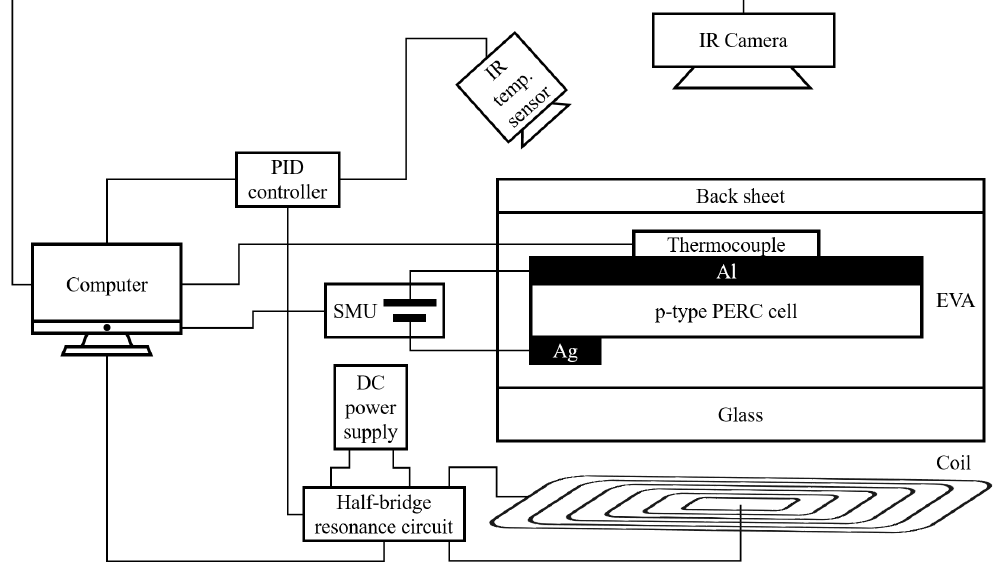
Figure 1. Passivated emmiter rear contact (PERC) solar cell module real-time regeneration state application and monitoring system.